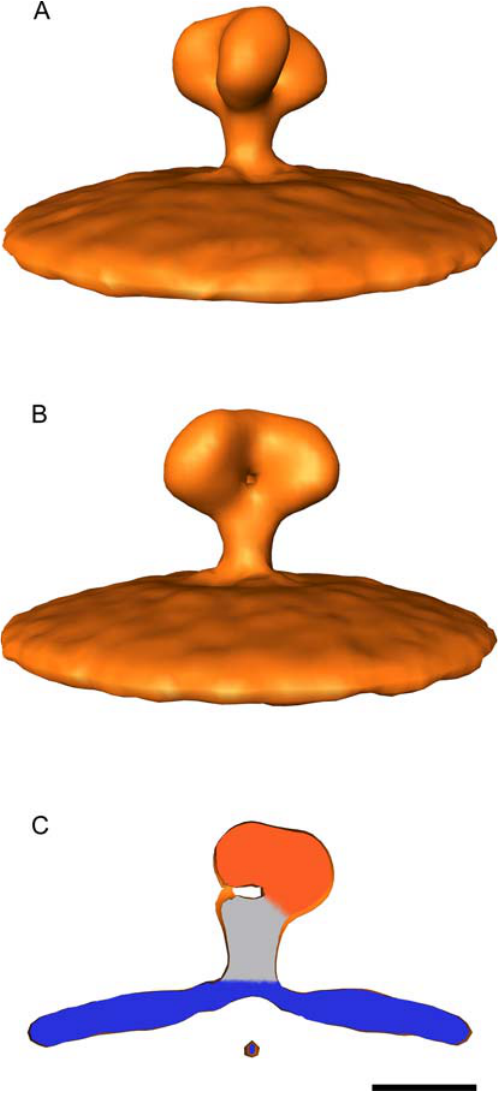
Figure 2. Reconstruction of the Env Spike, Filtered to 28 A˚, and Rendered (A) A rendered view of the complex at a 2 sigma contour level. The chirality of the distal portion is evident. (B) As in (A), rotated 60 8 around the 3-fold symmetry axis. (C) A slab through the density in the orientation represented in panel (B), revealing the cavity at the centre of the structure. The membrane is coloured in cyan. The volume corresponding to gp41 has been coloured in gray, and the remaining gp120 volume in orange. Scale bar ¼ 100